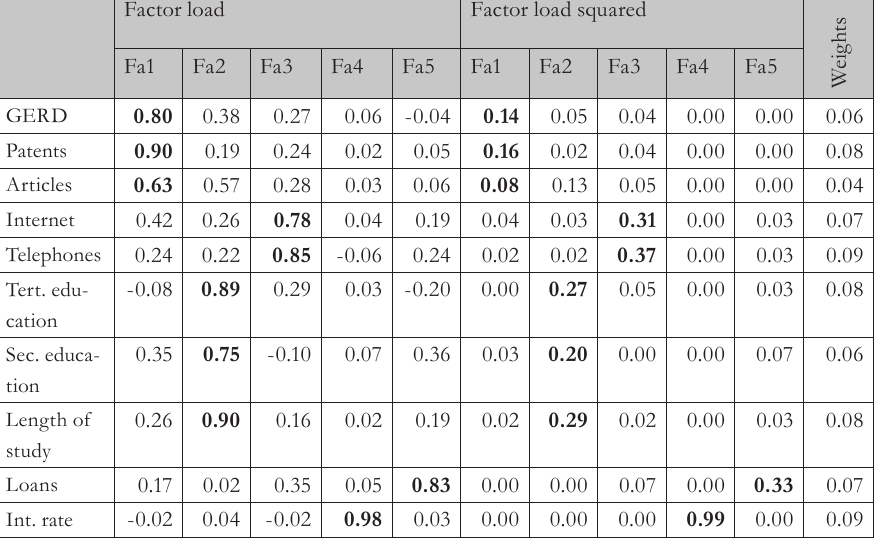
Tab. 2 – Factor analysis for the quality-based competitiveness of EU countries. Source: authors’ processing using Eurostat, ISI, the World Bank, AMECO, UNESCO, Worldwide Governance Indicators. Index of Economic Freedom